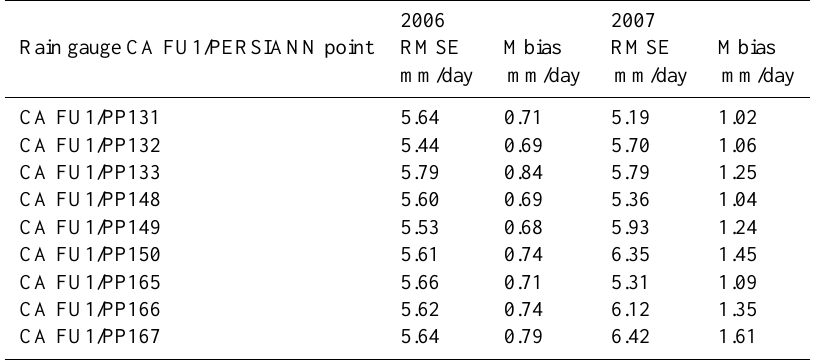
Table 3. Statistical analysis between Caudete de las Fuentes1 (CA FU1) rain gauge and of its nine PERSIANN neighbours (PP) for 2006 and